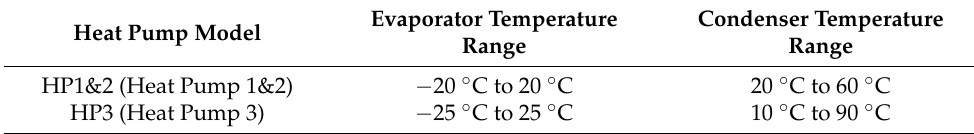
Table 3. Range of manufacturer’s